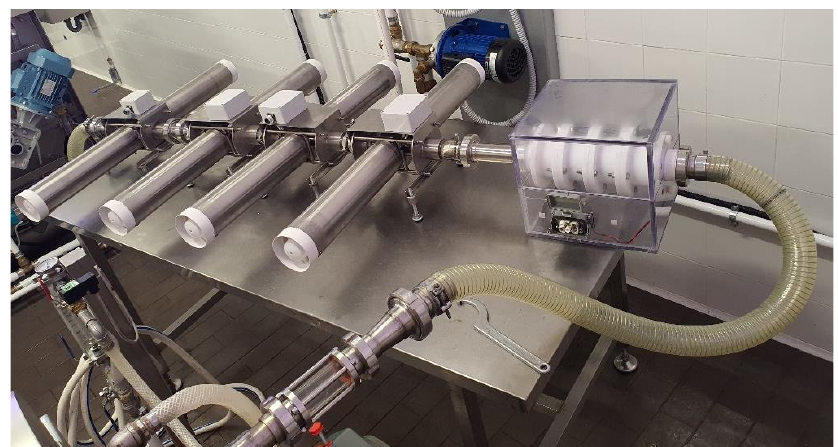
Figure 3. Continuous-flow extraction under combined US (C2FUT Srl) and PEF (Energy Pulse Systems), DSTF — University of Turin.